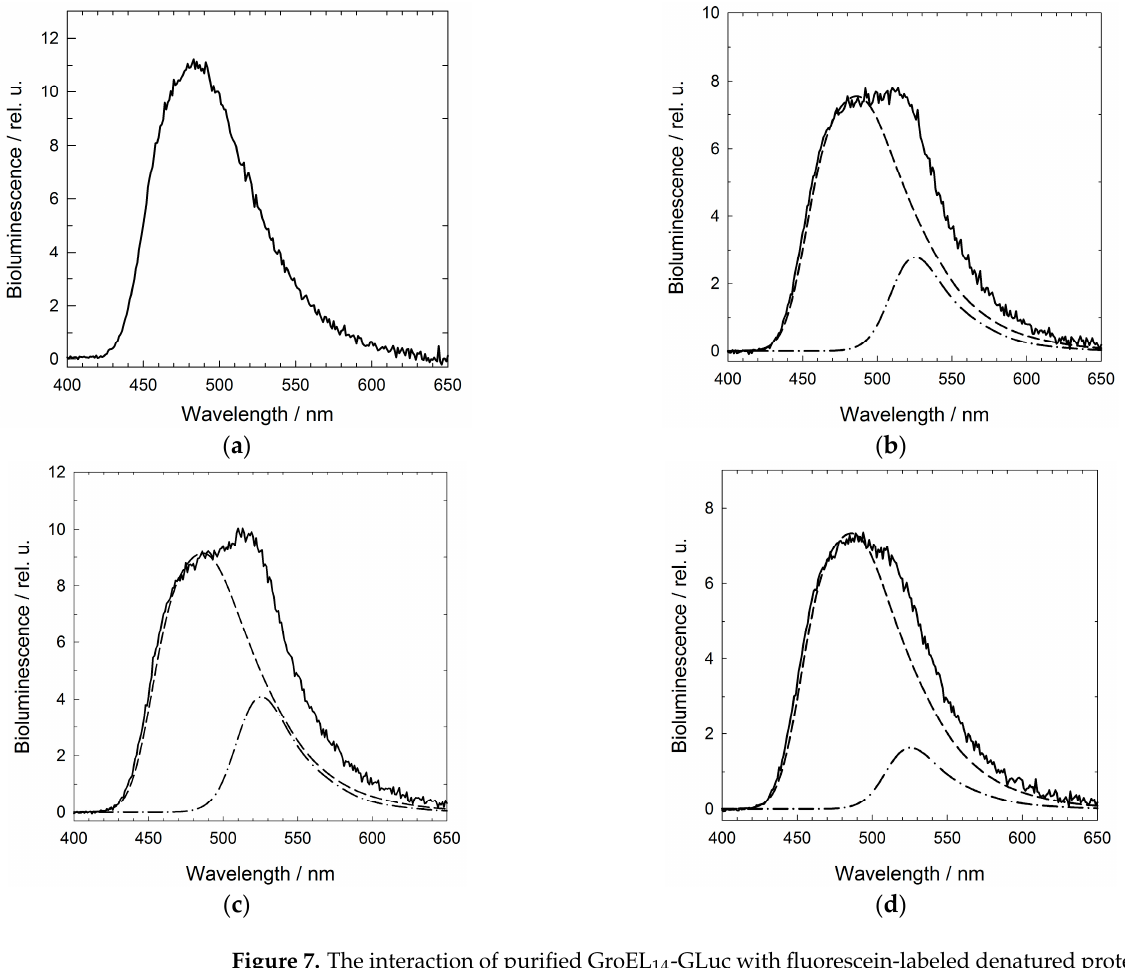
Figure 7. The interaction of purified GroEL 14 -GLuc with fluorescein-labeled denatured proteins monitored by BRET: the bioluminescence spectra of GroEL 14 -GLuc in the absence of denatured proteins ( a ) and in the presence of denatured lysozyme ( b ), α -lactalbumin ( c ), and malate dehydrogenase ( d ). The dashed lines show the contribution of bioluminescence to the spectrum; the dashed-dot lines are the contribution of BRET-induced fluorescein fluorescence.